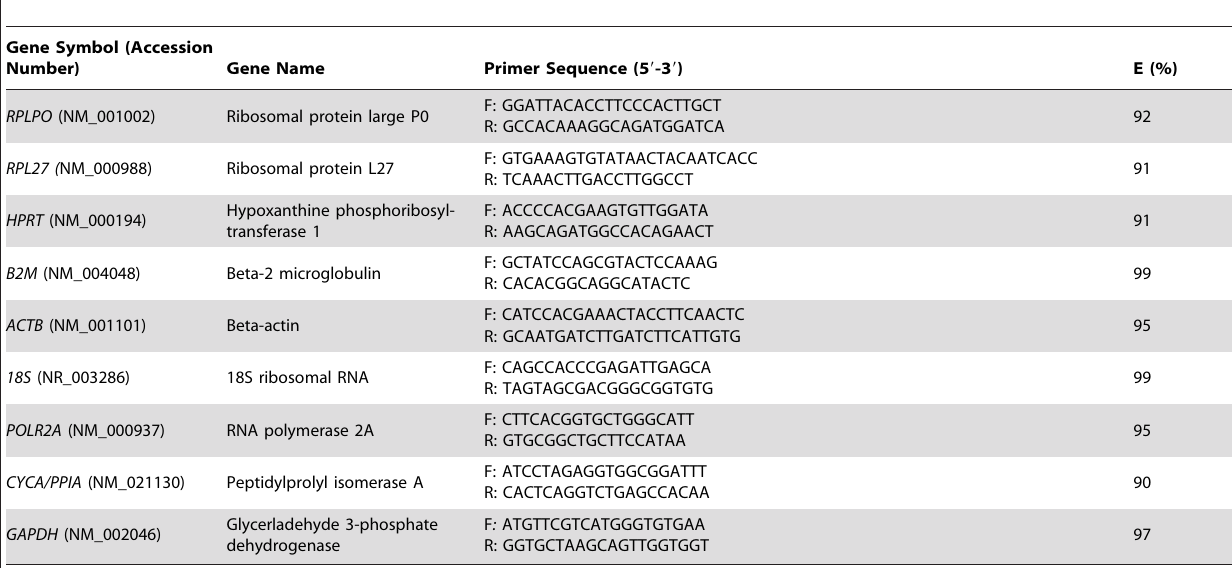
Table 2. Candidate reference genes with respective symbol, accession number, name, primer sequences and efficiency of amplification (E).